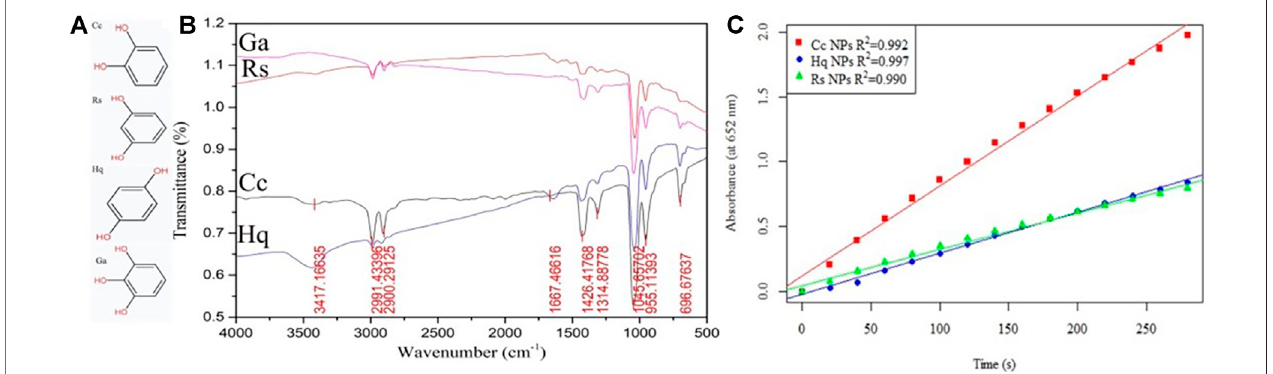
FIGURE 9 | (A) The molecular structure of Cc, Hq, Rs, Ga and (B) the infrared spectrum of the reduced colloidal gold (C) Part of Figure 5 .